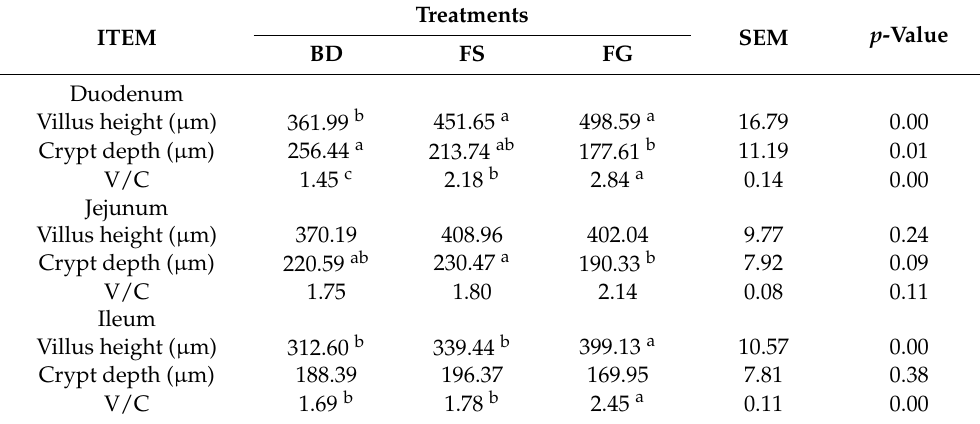
Table 4. Effect of different iron sources on intestinal morphology in weaned pigs.